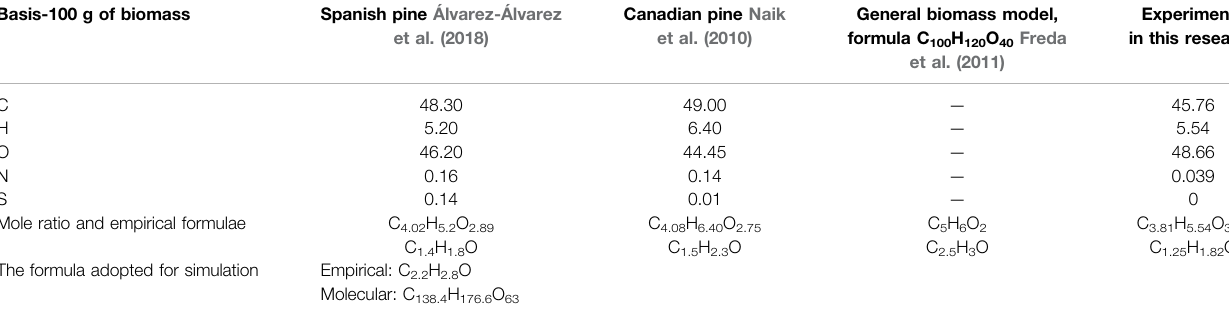
TABLE 1 | Determination of empirical and hecular formula using literature, experimental data and stoichiometric balance. Basis-100 g of biomass Spanish pine Álvarez-Álvarez et al. (2018)